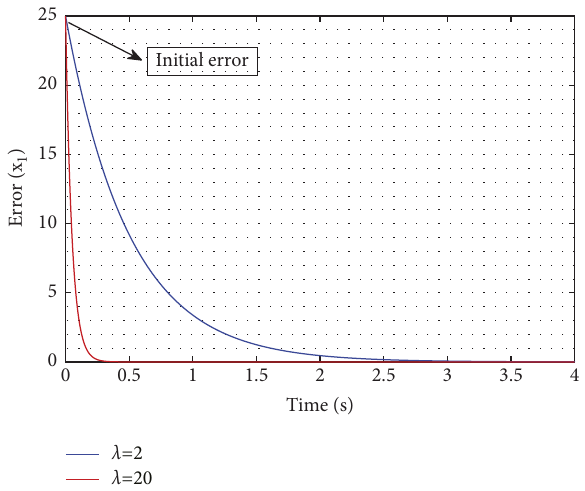
Figure 2: Error trajectory of CSMC with diferent values of λ